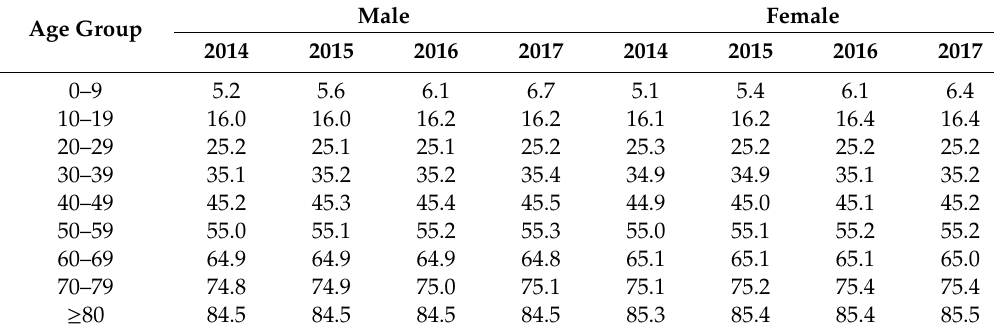
Table A3. Age of onset in Korea by sex and age,